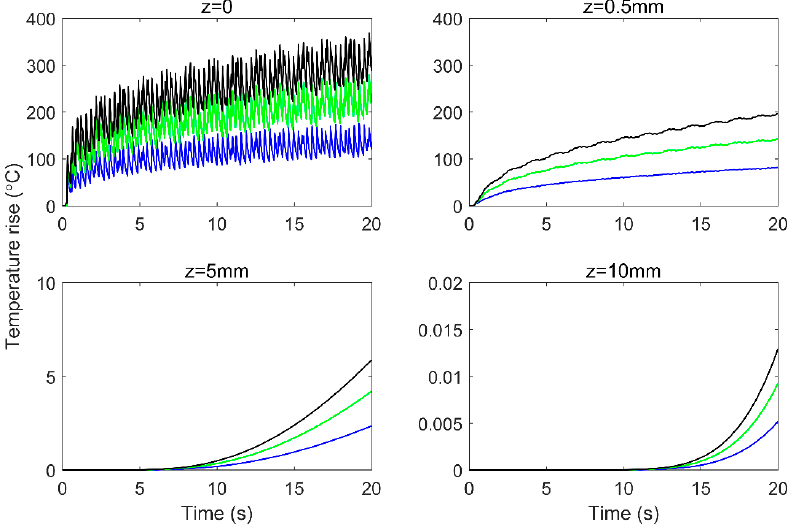
Figure 6. Temperature variation with time for w = 1960 N (blue), 3920 N (green) and 5880 N (black) (from bottom to top), z = 0 mm, 0.5 mm, 5 mm and 10 mm, v = 5 m/s.